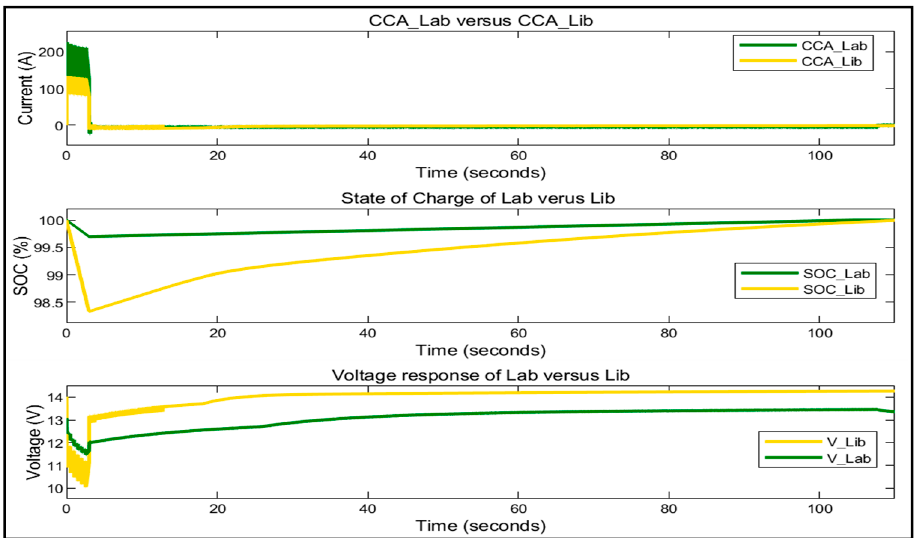
Figure 18. The percentage CCC, SoC , and voltage response of hybridized batteries during discharg- ing modes.